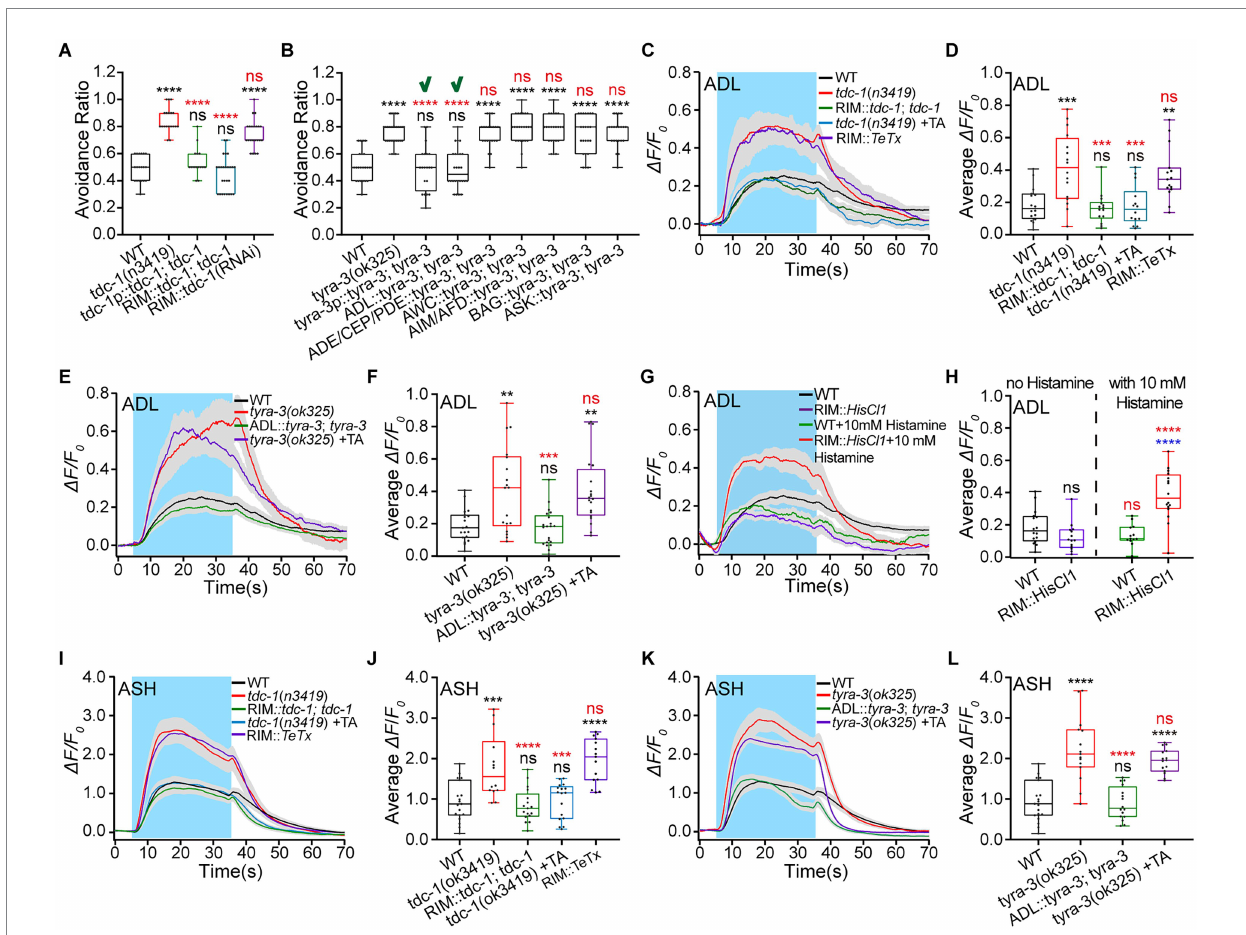
FIGURE 4 RIM inhibits hyperosmotic avoidance by inhibiting ADL via tyramine/TYRA-3 signaling. (A,B) Ratio of avoidance of a droplet of the 0.88 Osm glycerol/ M13 hyperosmotic solution in animals of indicated genotypes. “ √ ” indicates the success of restoring WT behavior by the genetic rescue indicated. (C–L) The somal calcium signals in paired ADL (C–H) and ASH (I–L) sensory neurons in response to the application of hyperosmotic solution in WT, mutant, and transgenic animals of indicated genotypes. (C,E,G,I,K) Curves of Ca 2+ transients presented as means (solid traces) ± SEM (gray shading) with cerulean background indicating the application of 0.88 Osm glycerol/M13 solution; (D,F,H,J,L) Box plots of the average intensity of Ca 2+ signals of the ON response during glycerol/M13 solution perfusion with each dot representing the data from each tested worm. Heat maps of Ca 2+ signals are shown in Supplementary Figure S4. Statistical significance is indicated as and in different colors: ns, not significant, ** p < 0.01, *** p < 0.001, and **** p < 0.0001; black, the tested vs. the WT; red, the gene rescued vs. the related mutant, or the histamine treated vs. histamine untreated of the same genotype (in H ); blue, the tested vs. the WT under histamine treatment (in H